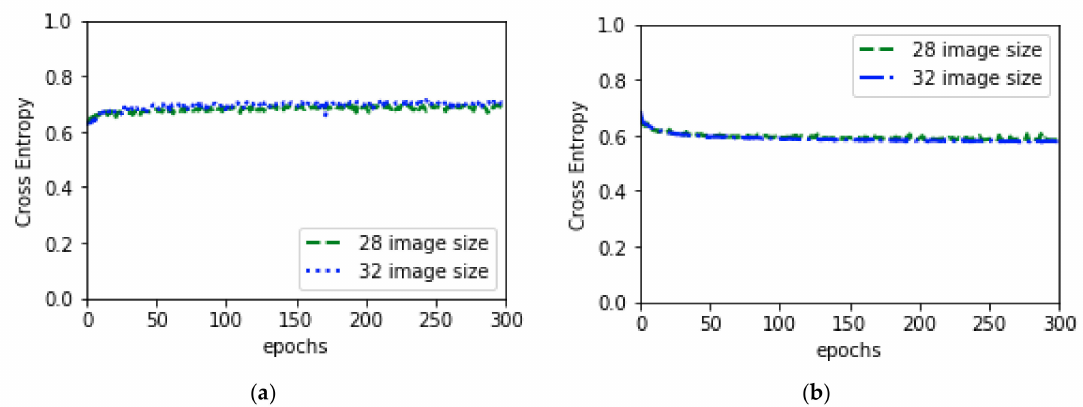
Figure 10. Training behavior of Autoencoder after freezing encoder layer: ( a ) depicts the validation accuracy for image (32, 32) and (28, 28) and ( b ) depicts validation loss for image (32, 32) and (28, 28) while training Autoencoder 300 epochs.